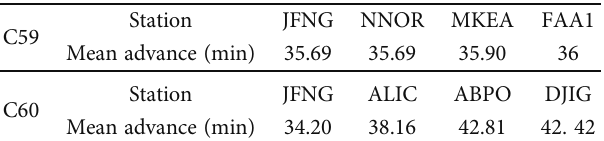
Table 3: Summary of the start times of C59 and C60 maneuvers detected by di ff erent